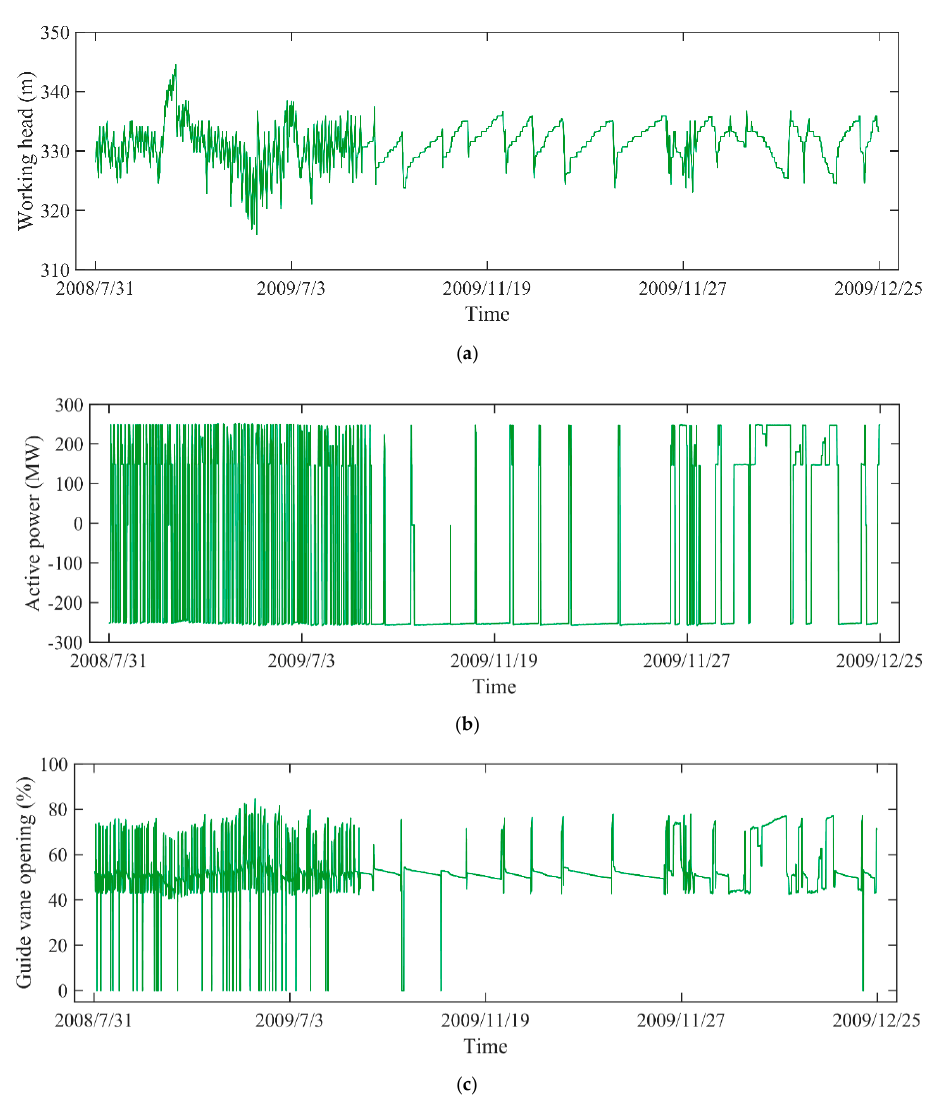
Figure 3. The monitoring data of PSU: ( a ) working head, ( b ) active power, ( c ) guide vane opening.